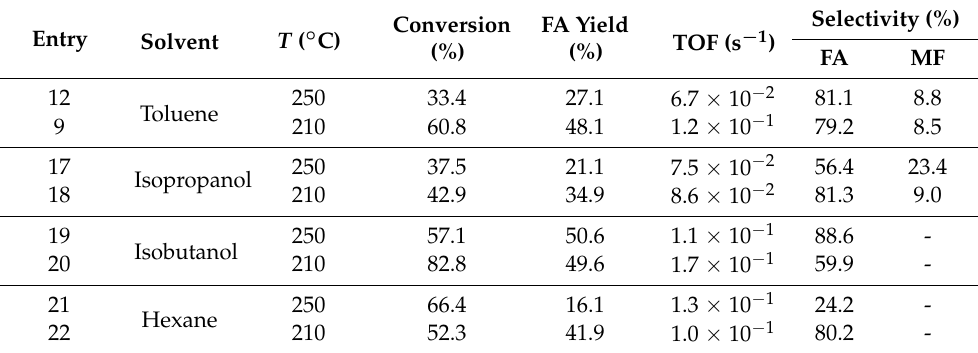
Table 3. Selectivity and conversion for furfural hydrogenation with Pt/B 3 wt % in toluene, isopropanol, isobutanol, and hexane at 1500 psi H 2 pressure for 2